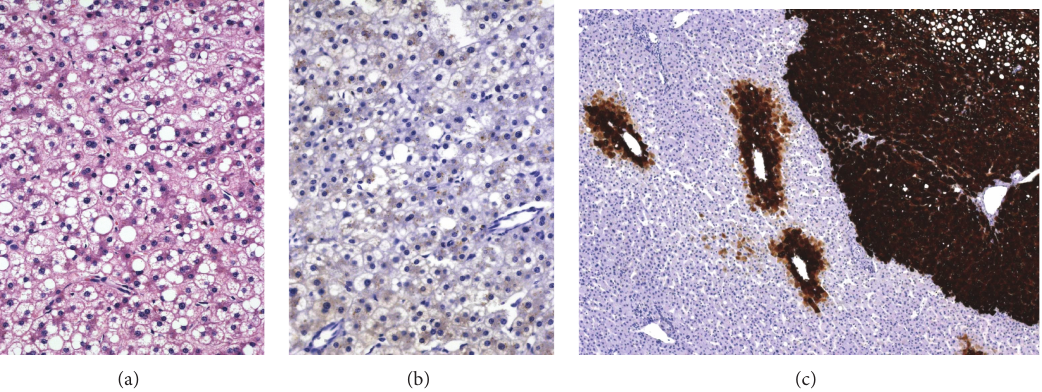
Figure 1: 𝛽 -catenin-activated/ HNF1 𝛼 -inactivated HCA ((a), Obj × 20) with negative L-FABP ((b), Obj × 20), and strong positive GS ((c), Obj × 5) staining. Note the normal GS staining around the perivenular areas of the adjacent normal liver on the